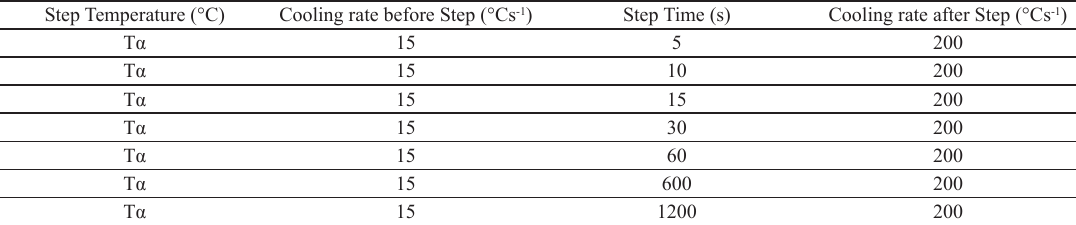
Table 3. SQ heat treatment routes used to characterize the kinetics of ferrite formation at Tα temperature. Step Temperature (°C)